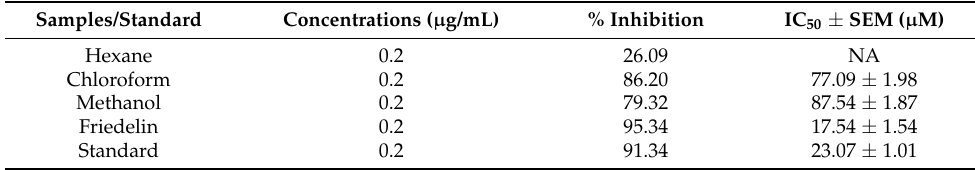
Table 2. α -Glucosidase-inhibiting effects of crude extract/fractions and compound 1 extracted from Syzygium cumini bark.